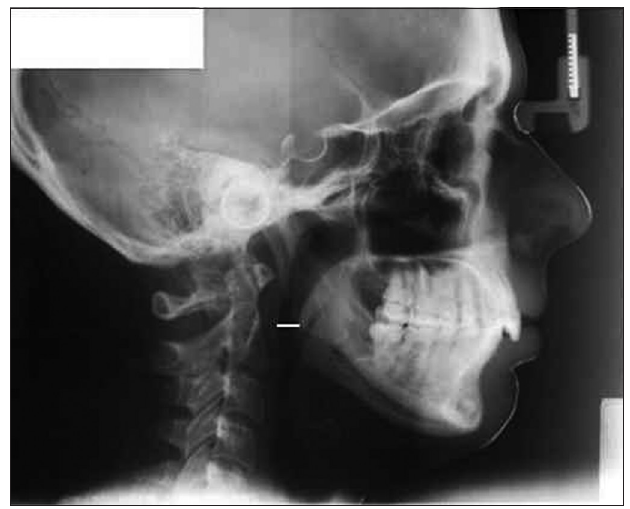
Figura 1. Medida cefalométrica PAS (via aérea inferior): largura da faringe no ponto onde, radiograficamente, a borda posterior da língua cruza com a borda inferior da mandíbula até o ponto mais próximo da parede posterior da